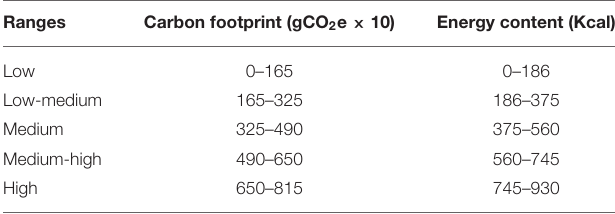
TABLE 1 | Multiple choice ranges of carbon footprint and energy content.